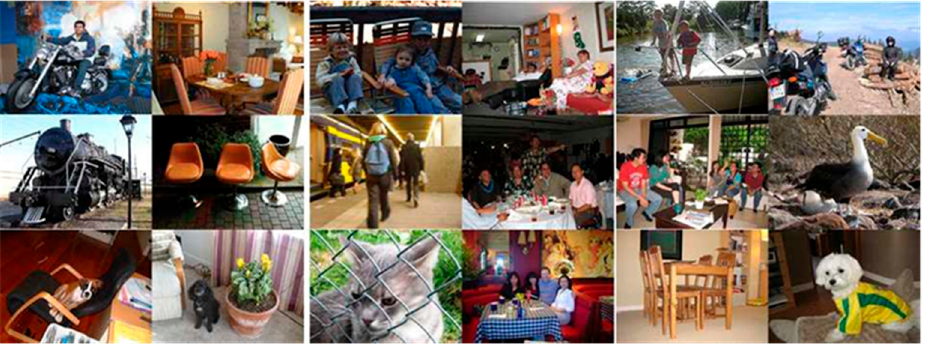
Figure 4. PASCAL VOC 2012 database images.